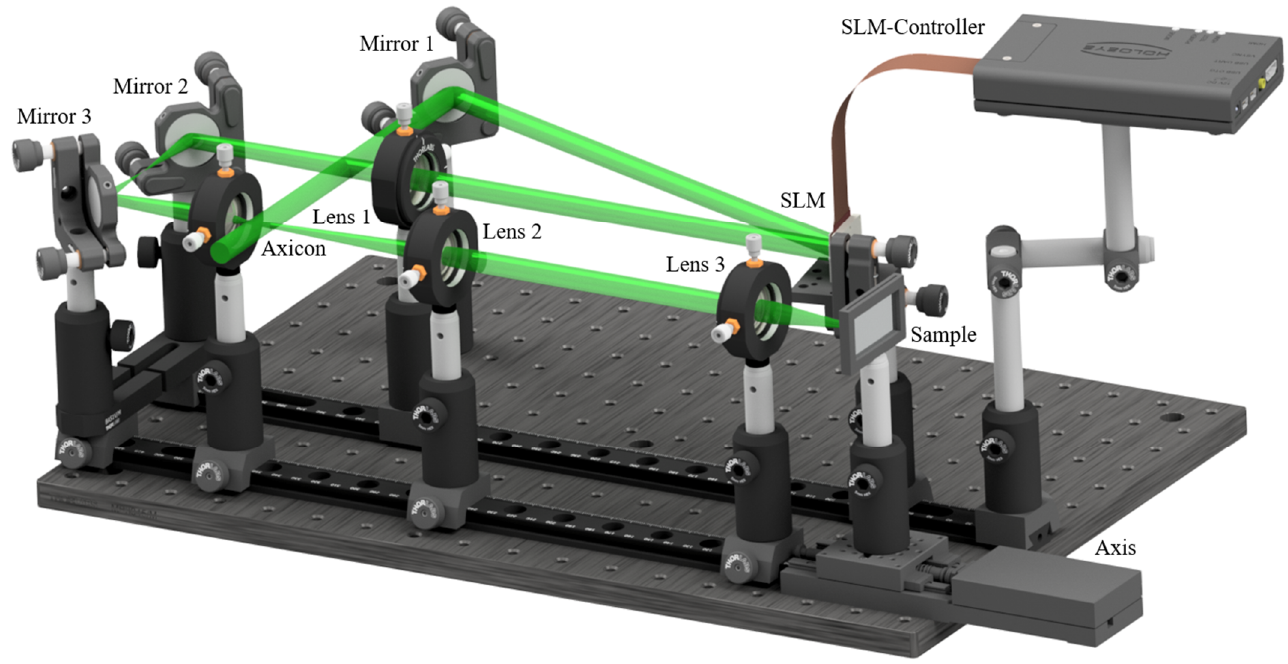
Figure 1. Schematic illustration of the optical system for multi-Bessel beam generation using a spatial light modulator, a 4f-telescope, an axicon, focusing lenses, and an exemplary sample in form of a metal sheet, which can be replaced by a camera for recording the beam profiles.